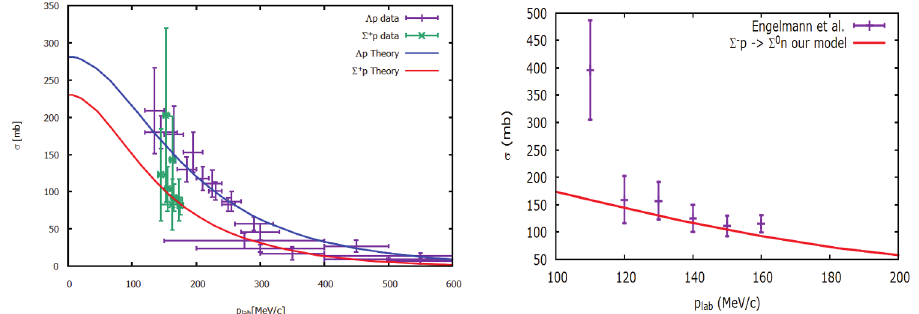
Figure 1. Calculated cross section (theory) for Σ + p (left), Λ p (left) and Σ − p ⇒ Σ 0 n (right) channels plotted in comparison to the bubble chamber data